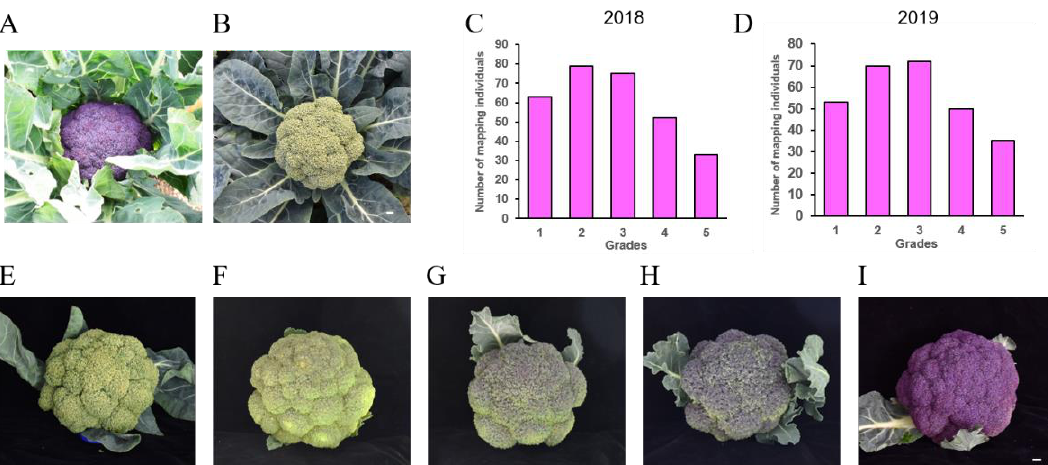
Figure 1. Phenotypes of the parents and F2 individuals and their frequency distributions. ( A ) Maternal line BT 126; ( B ) paternal line, SN 60; ( C , D ) the frequency distribution of the purple head trait in the F2 populations with 302 and 280 individuals planted in 2018 and 2019, respectively; ( E – I ) phenotype of two F2 populations with 1st to 5th grades of head color. The DNAs of 30 F2 individuals with extreme phenotypes (1st and 5th grade) were used to develop high anthocyanin and low anthocyanin bulks; scale bar = 1cm.